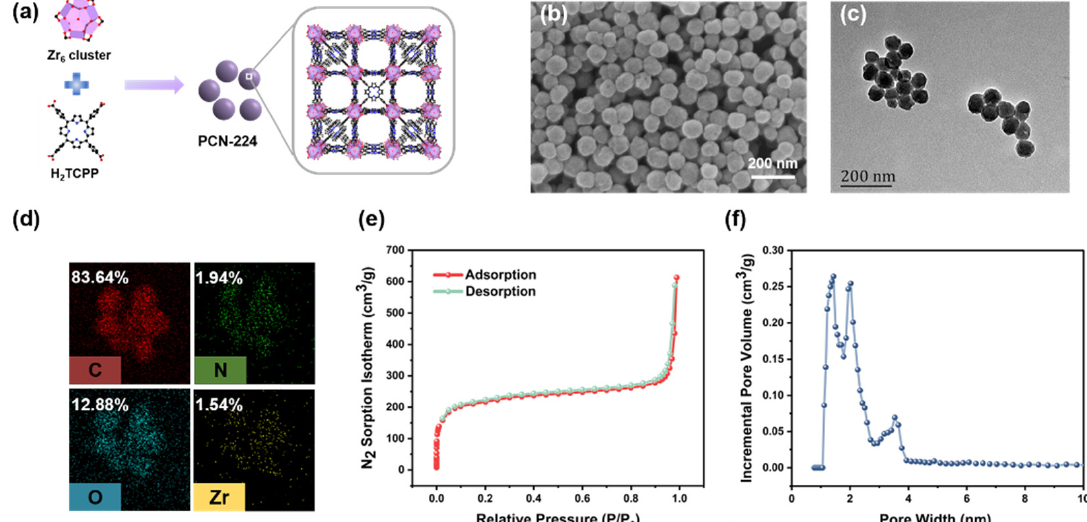
Figure 1. ( a ) The illustration of PCN − 224 NPs 3D framework structure. ( b ) The SEM image of PCN − 224 NPs. ( c ) The TEM image of PCN − 224 NPs and corresponding TEM elemental mappings is shown in ( d ). ( e ) The N 2 adsorption-desorption isotherms of PCN − 224 NPs, and the corresponding pore size distribution is displayed in ( f ).